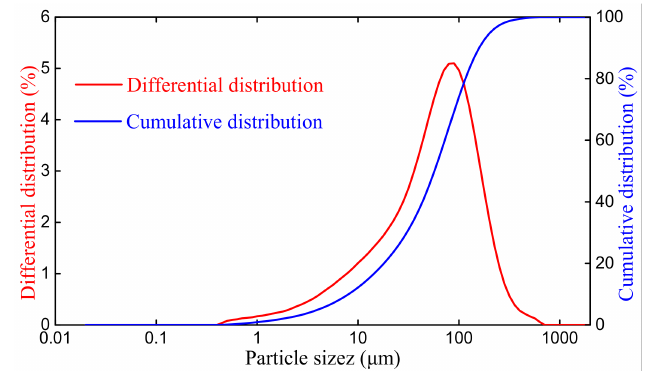
Figure 2. Particle size distribution of unclassified tailings. Table 1. Main chemical elements in the tailings, cement and crushed mine waste rocks. Component Tailings (wt.%) Crushed Mine Waste Rocks